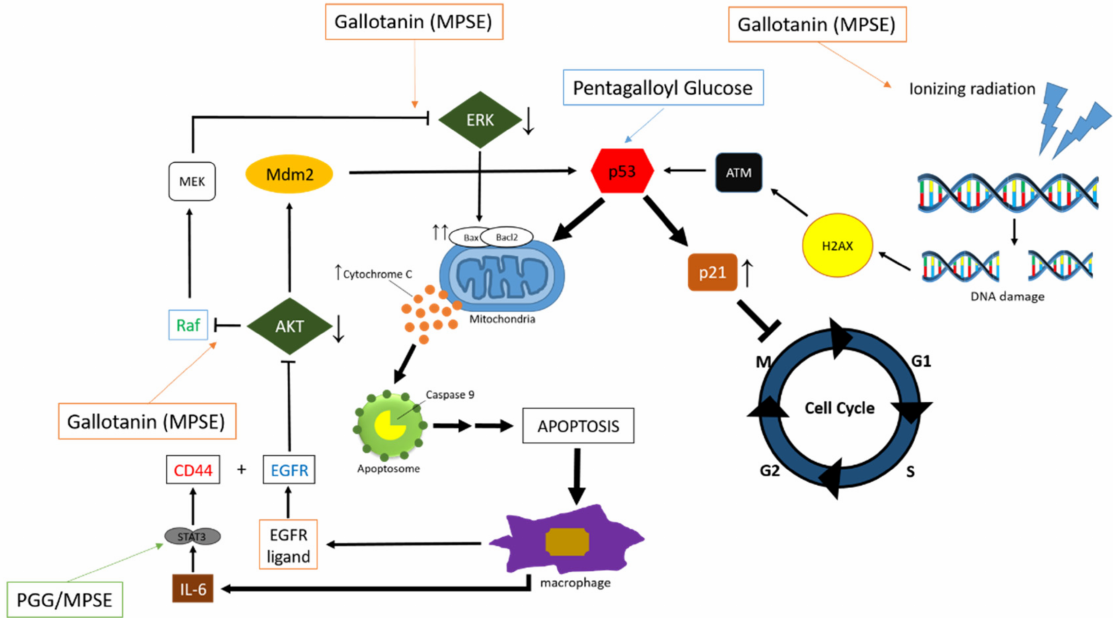
Figure 4. Anticancer molecular mechanisms of B. macrophylla